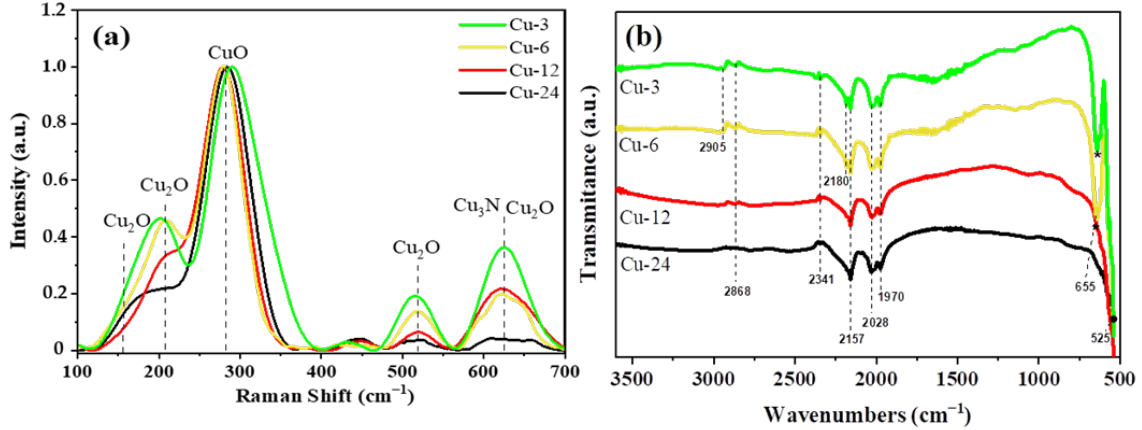
Figure 4. ( a ) Normalized Raman spectra and ( b ) FTIR spectra of the mixtures of the nanocomposites. The FT-IR spectra, as shown in Figure 4b, highlight the vibrational bands of the or- ganic and inorganic moieties present in the nanocomposites. FT-IR indicates changes in the framework configurations of the nanocomposites via shifts in the bands as a function of synthesis time. In the FT-IR spectra of the Cu-3 and Cu-6 samples, the peak located at 2868 cm −1 corresponds to the stretching vibrational mode of the Cu-O bonds from the